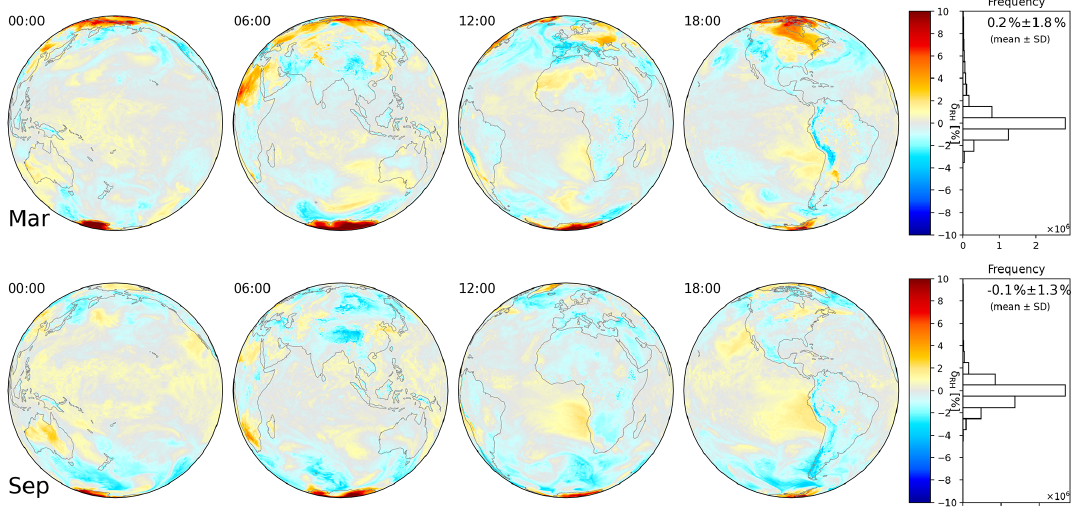
Figure C2. Deviation δ RH according to Eq. (19) for ERA5 at 00:00, 06:00, 12:00, and 18:00UTC on 18 March (top) and 18 September (bottom) 2018. The projection focuses on daytime for each time step. On the right, the frequency distribution and mean and SD are given for all hourly outputs of the respective